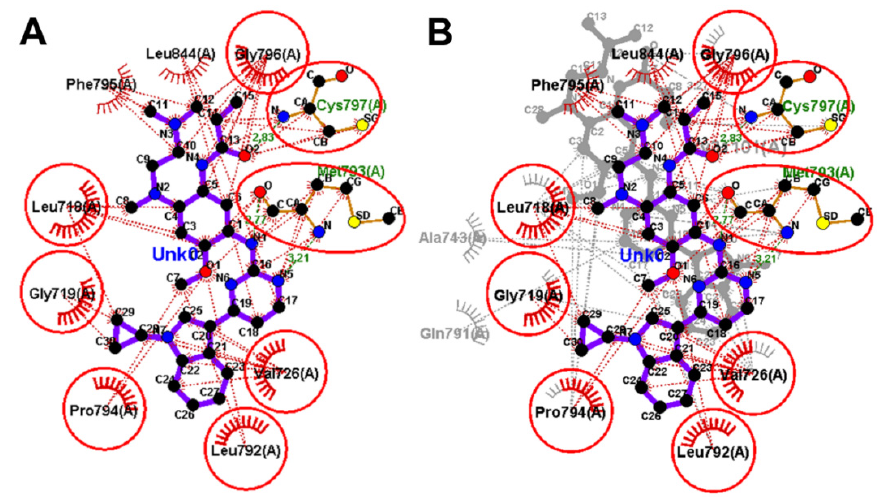
Figure 13. Binding interactions of almonertinib (shown as purple sticks) into EGFR (pdb: 4ZAU): ( A ) the docked almonertinib; ( B ) superposed LigPlot view of the docked almonertinib overlaid with the co-crystallized osimertinib (gray sticks), red circles/ ellipses show the equivalent interactions of the two molecules, hydrogen bond interactions are shown in olive green dotted lines (Met793, and Cys797) and hydrophobic interactions are shown in brick red dotted lines.